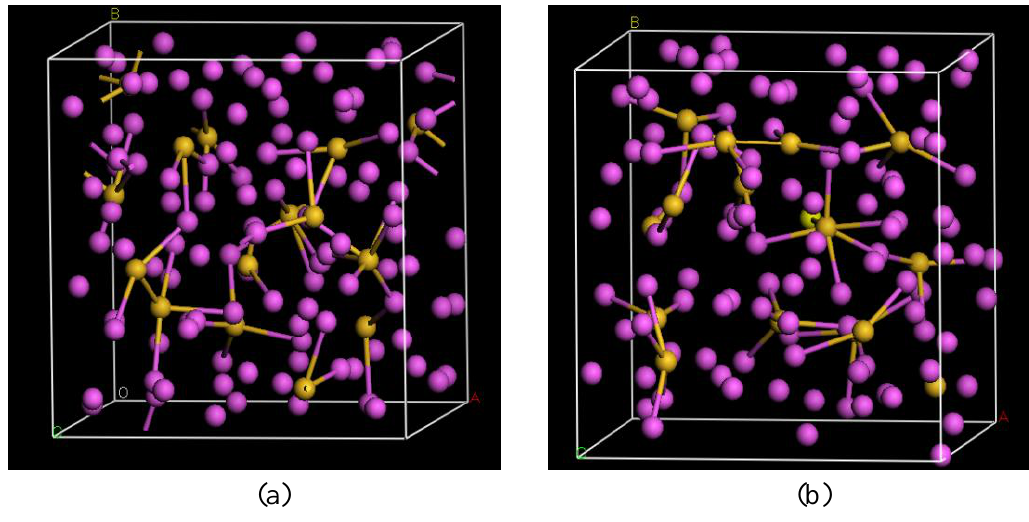
Figure 26. ( a ) Amorphous atomic structure of the 12 at %Si supercell, a -Al12at%Si. The plateau temperature is 840 K, just below the melt; ( b ) Liquid-amorphous (see Refenrence 96) atomic structure of the 12 at %Si supercell, la -Al12at%Si. The plateau temperature is 920 K, above the melt. Silicon atoms are in